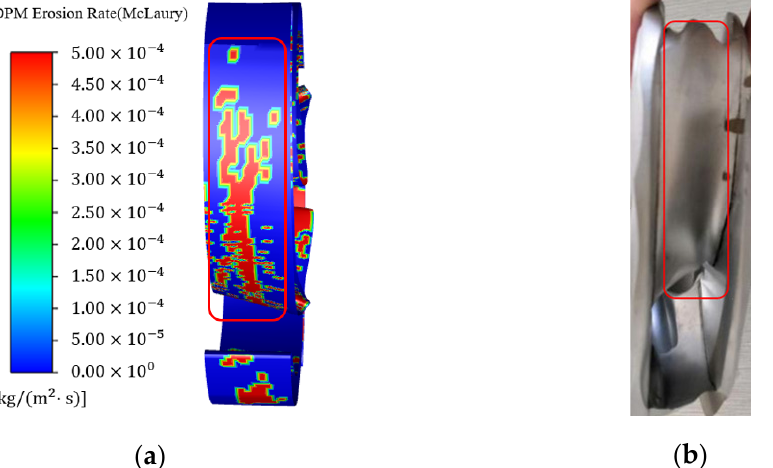
Figure 8. Wear comparison at middle section of blade pressure surface: ( a ) simulation; ( b ) experiment.